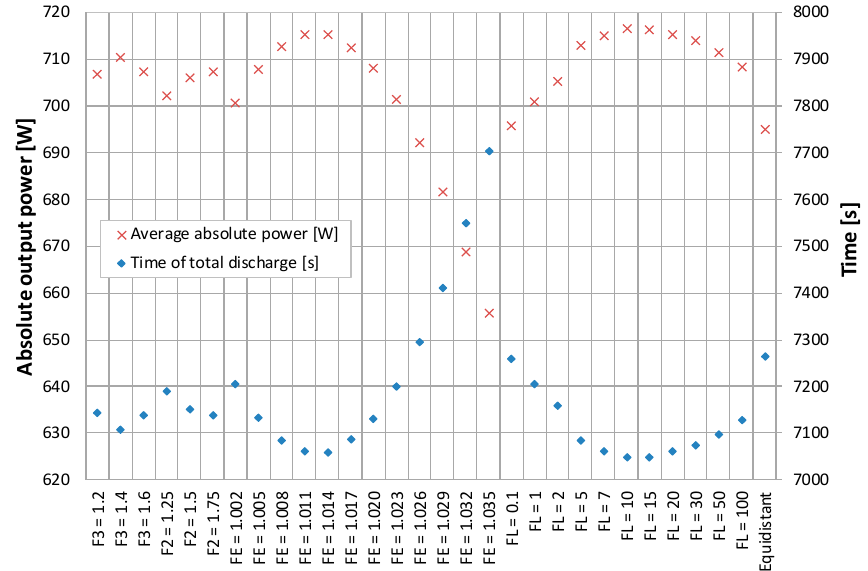
Figure 5. Absolute average power until total storage discharge of all examined arrangements of fins.